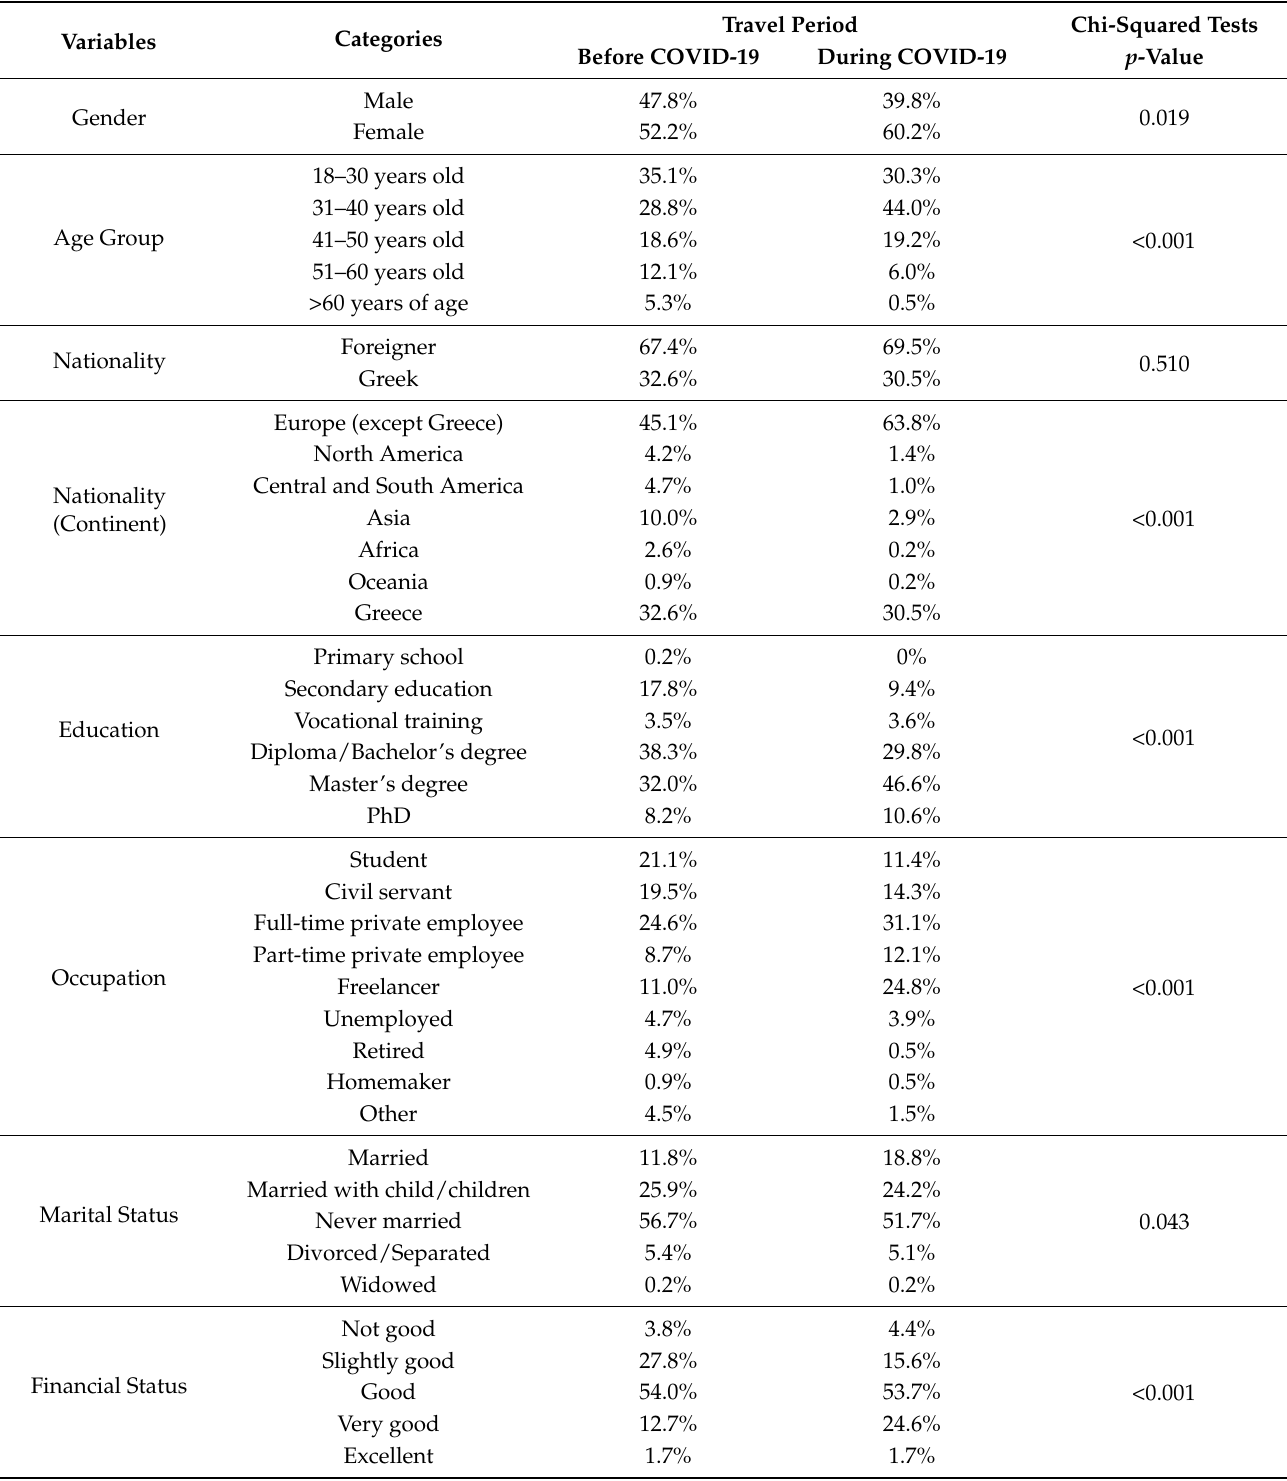
Table 1. The distribution of the sociodemographic profile in each